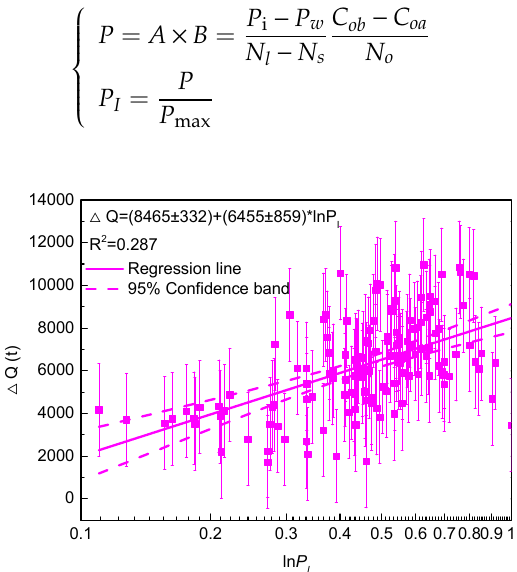
Figure 6. Production increase versus Production composite index.